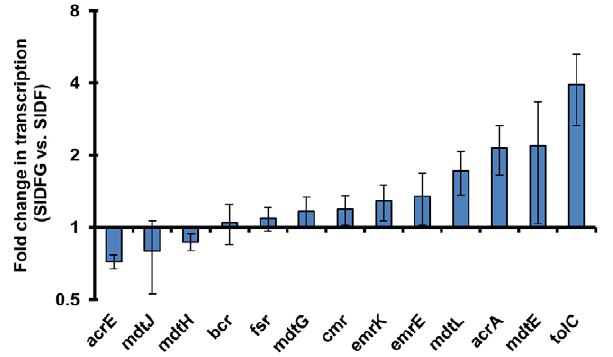
Figure 5. Efflux pumps were not repressed in the strain overexpressing dxs-idi-ispDF-ispG. Transcription fold change of efflux pump encoding genes upon ispG overexpression; bcr, mdtJ, mdtH, mdtA, mdtG, cmr, emrK, emrE, fsr, mdtL and acrA were known genes encoding E. coli efflux pumps. Transcriptions of the following efflux pump encoding genes were too low to be accurately quantified Figure 6. Analysis of bacteria other than E.coli . Intracellular DXP